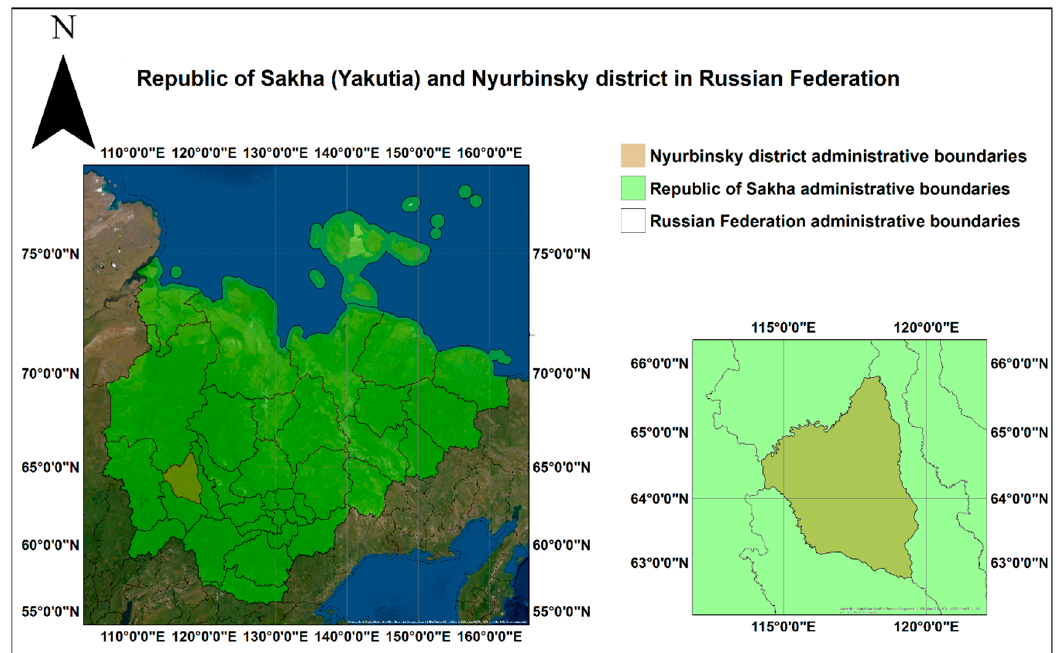
Figure 1. The geographical extent of the study area (source: Earthstar Geographics, low resolution 15 m imagery).